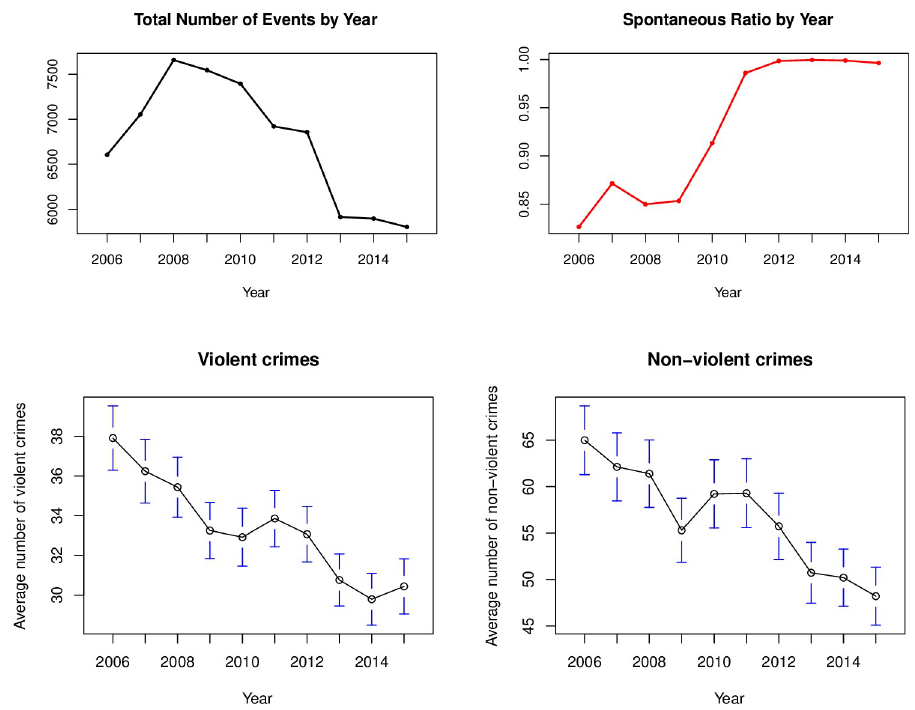
Fig 1. Top row : Yearly trends in the total number of block party events and the spontaneous proportion of block party events. Bottom row : Yearly trends in the number of violent and non-violent crimes per year.